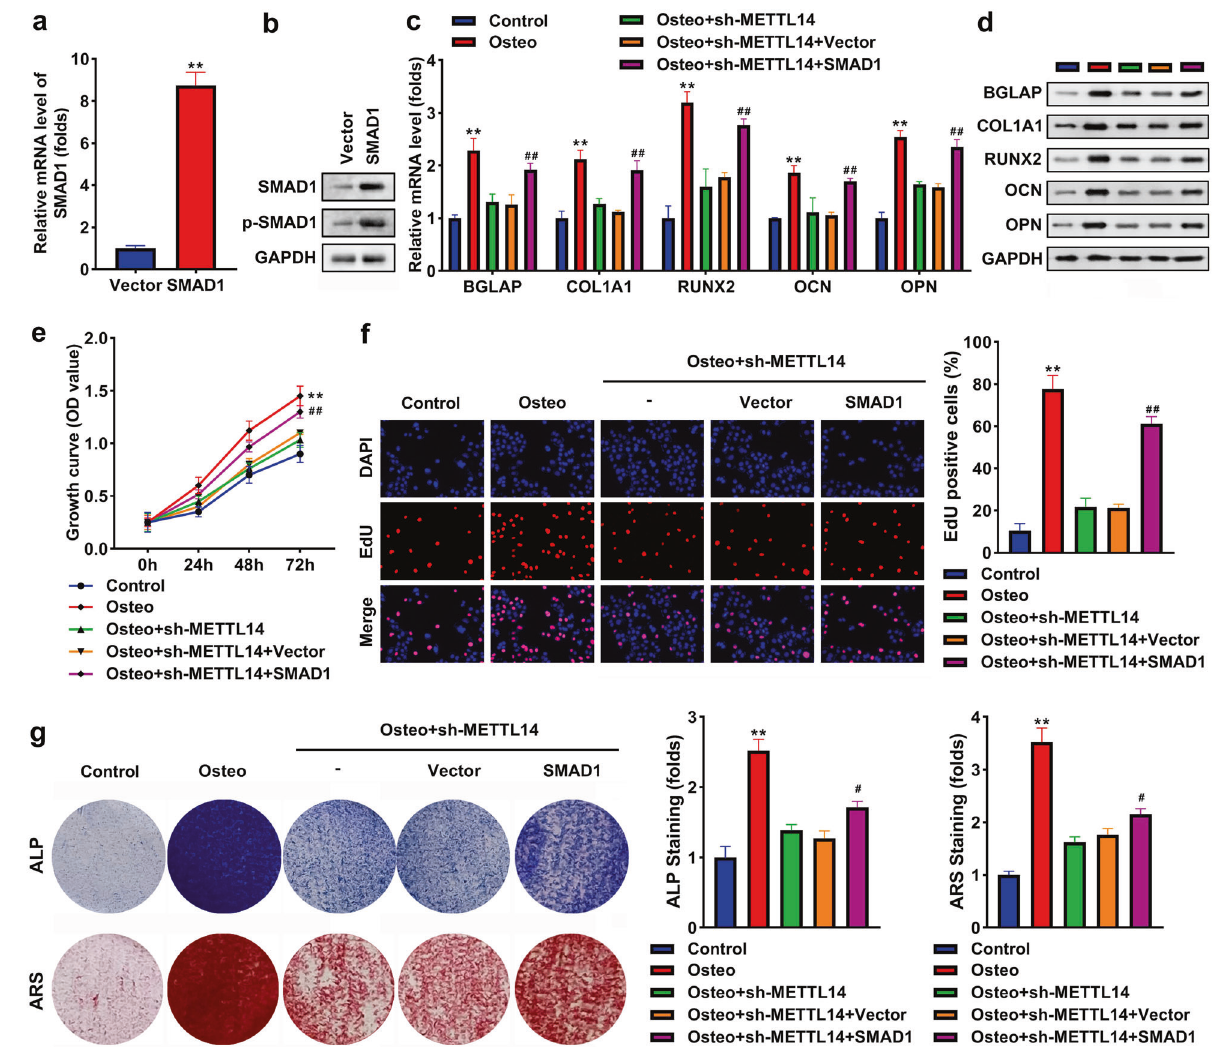
Fig. 8 Knockdown of METTL14 suppresses osteogenic differentiation by modulating SMAD1. a SMAD1 expression at mRNA level post- transfection. b SMAD1 and p-SMAD1 protein levels post-transfection. c The mRNA expression of BGLAP, COL1A1, RUNX2, OCN, and OPN. d The protein levels of BGLAP, COL1A1, RUNX2, OCN, and OPN. e Cell growth was assessed using the CCK-8 assay. f Cell proliferation was assessed using EDU assay. g Osteogenesis was analyzed using an ALP staining assay and an ARS staining assay. The staining intensity was quanti fi ed. ** P < 0.01 in ( a ) vs. vector. * *P < 0.01 in ( b – g ) vs. control. ## P < 0.01 vs. osteo + sh-METTL14 +